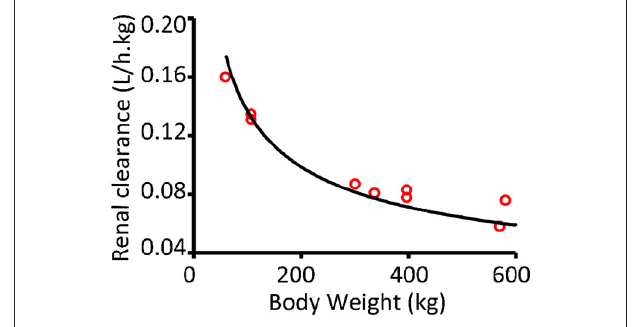
FIGURE 2 | Renal clearance curve fitted according to Equation 12.